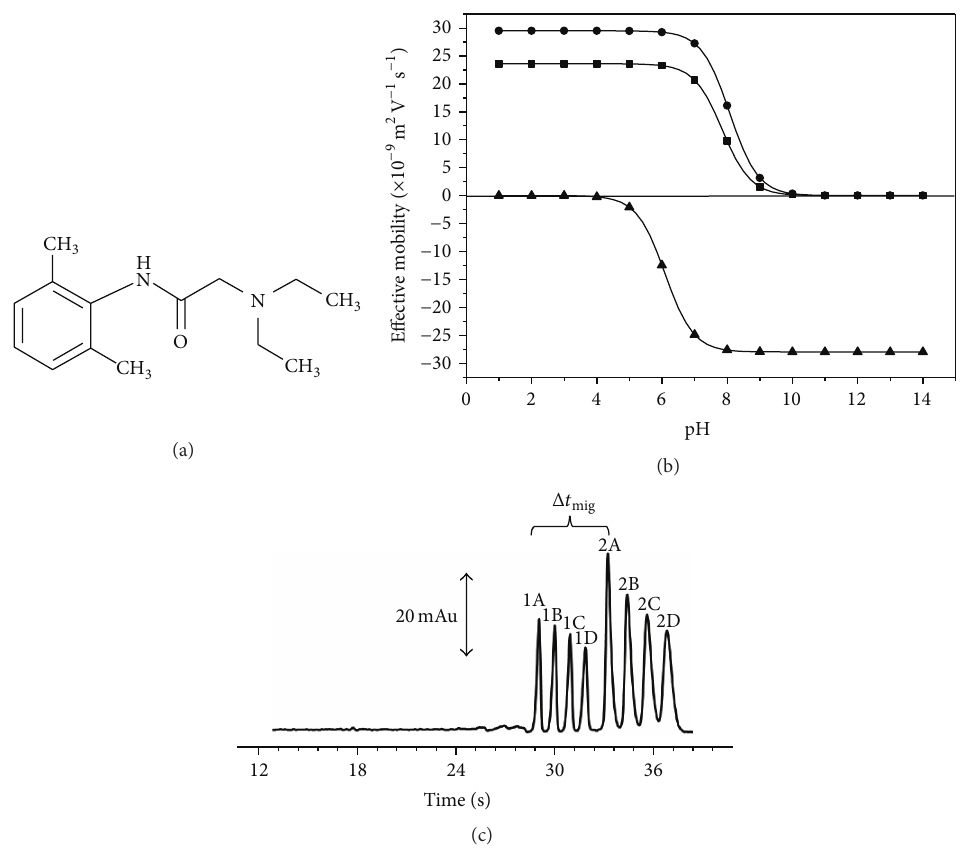
Figure 1: (a) Structure of lidocaine. (b) Effective mobility curves for lidocaine (- ◼ -), TRIS (- e -), and MES (- 󳵳 -). (c) Electropherogram of a pharmaceutical formulation using the optimized method by CZE with multiple injections. Peaks: 1: benzylamine (IS); 2: lidocaine; A, B, C, and D represent the first, second, third, and fourth injection, respectively. BGE composed by TRIS 20 mmolL −1 and MES 40mmol L −1 at pH 6.1. EOF mobility measured 33.1 × 10 −9 m 2 V −1 s −1